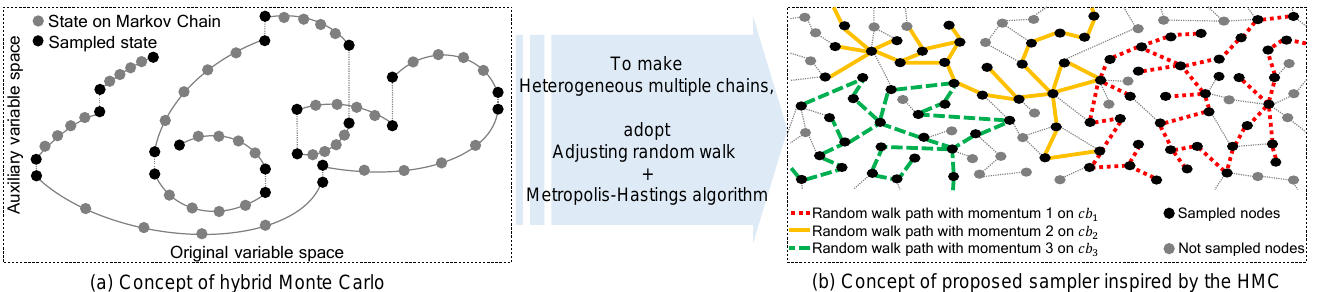
Figure 1. Diagrammatic explanation of what inspired the proposed network sampling method with heterogeneous multiple chains (best viewed in color).